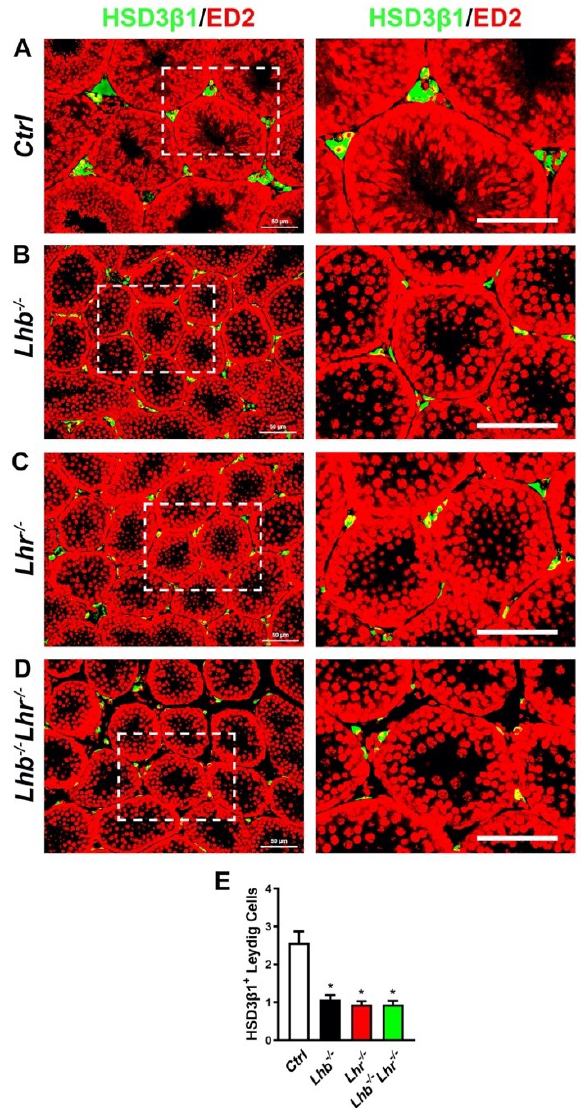
Figure 2. Immunofluorescence analysis of Leydig cells in testis sections. HSD3 β 1 + Leydig cells are visualized in interstitial spaces in testis sections obtained from control mice ( Ctrl ; ( A )), mice lacking either only LH ( B ), or only LHR ( C ) or both LH and LHR ( D ). Regions indicated in white squares are shown as higher magnification images in right side panels in each case. Nuclei are stained in red. White bar represents 50 μ m. HSD3 β 1 + Leydig cells in multiple interstitial spaces are quantified ( E ). Loss of LH or LHR or both results in significant suppression (58 – 64%) of HSD3 β 1 + Leydig cells compared to the control group (* p < 0.05, single or double mutant vs. Ctrl ; at least 100 interstitial spaces per genotype) but no differences were noted in HSD3 β 1 + Leydig cells between single or double mutant sections ( p > 0.05, single or double mutant vs. Ctrl ; at least 100 interstitial spaces per genotype).